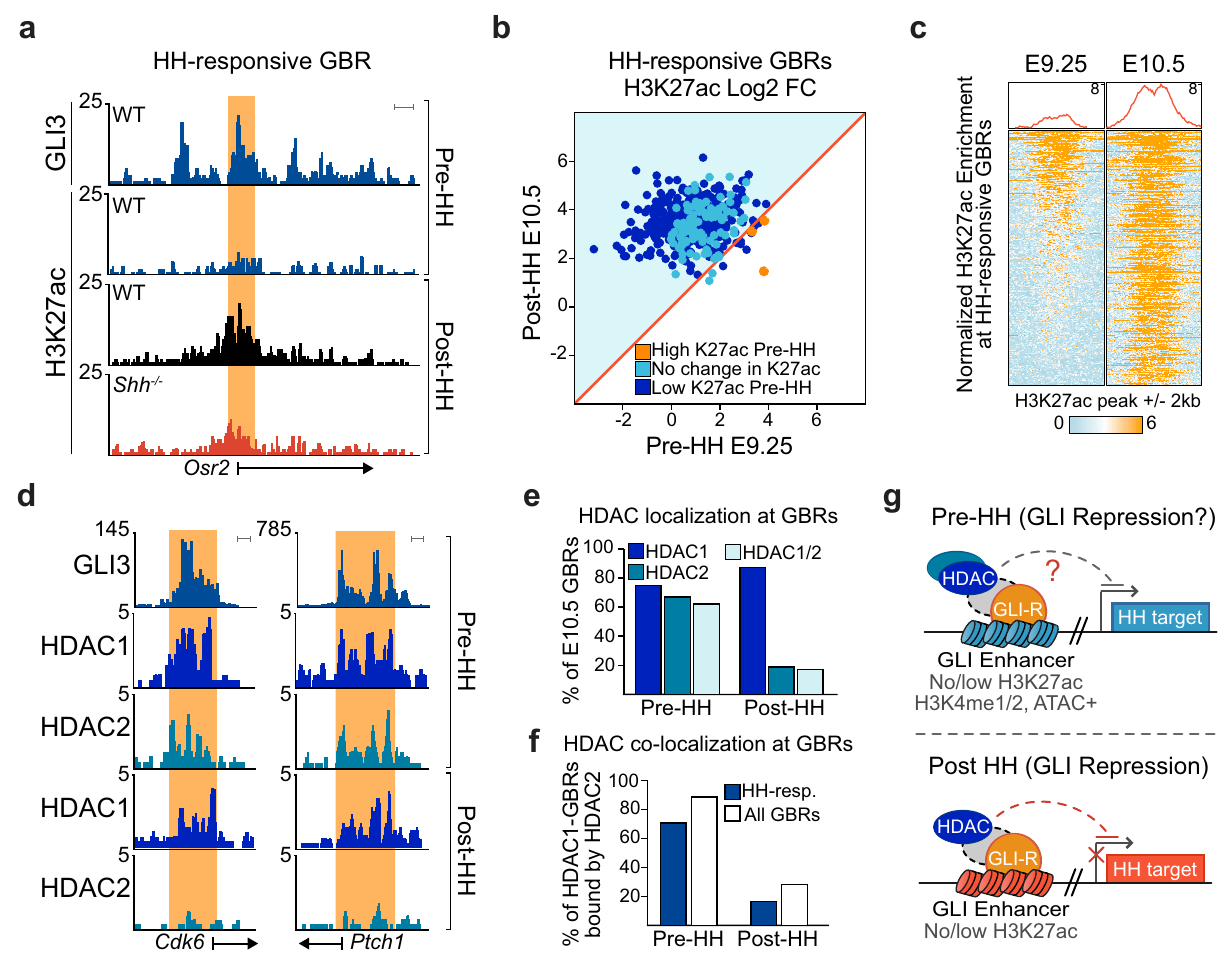
Fig. 2 GLl3 binding regions have reduced enrichment of H3K27ac and are enriched with HDACs in pre-HH limb buds. a H3K27ac ChlP-seq tracks showing a E9.25 (21-23 S) GLl3-bound HH-responsive GBR with reduced acetylation in E9.25 WT limb buds compared to E10.5 WT limbs 10 (note that the levels of enrichment are comparable to E10.5 Shh − / − limbs). b Scatter plot of H3K27ac enrichment at HH-responsive GBRs in pre- and post-HH 10 WT limbs. HH-responsive GBRs with signi fi cant reductions (FDR < 0.05) in H3K27ac at E9.25 compared to E10.5, are denoted in dark blue, while the 3 GBRs with signi fi cantly higher H3K27ac in E9.25 limbs are in orange (FDR < 0.05 n = 2). c Heatmap of H3K27ac ChlP-seq indicating relative